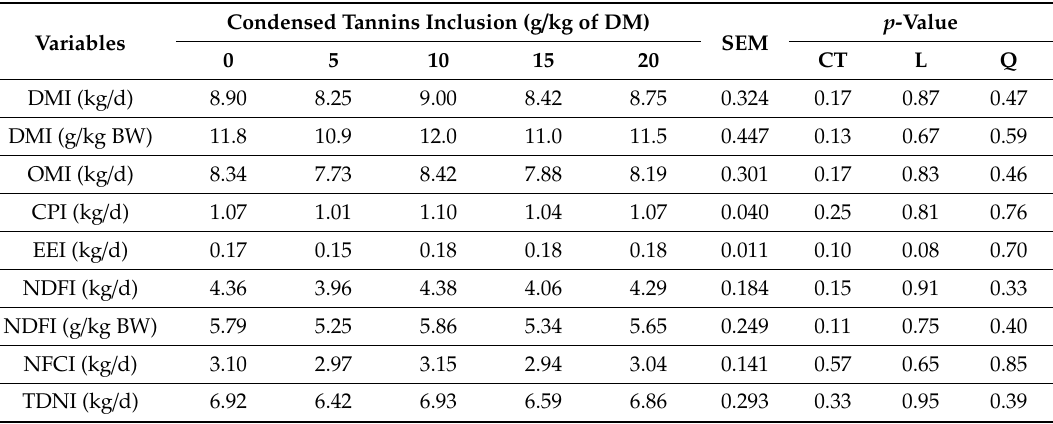
Table 3. Intake of dry matter and nutrients of steers receiving diets with increasing levels of condensed tannins extract from Acacia mearnsii .